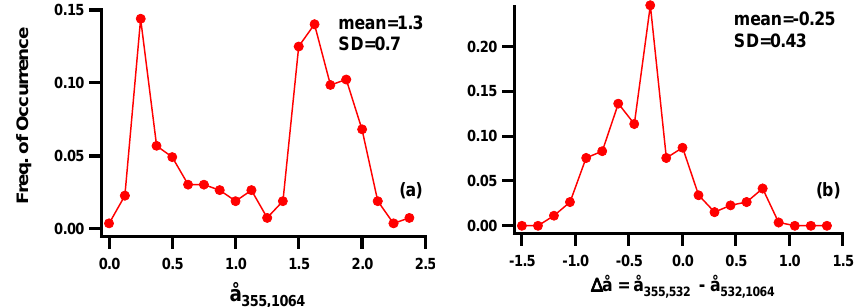
Fig. 16. Frequency of occurrence plot of (a) å 355 , 1064 (z) and (b) 1 å (z) .